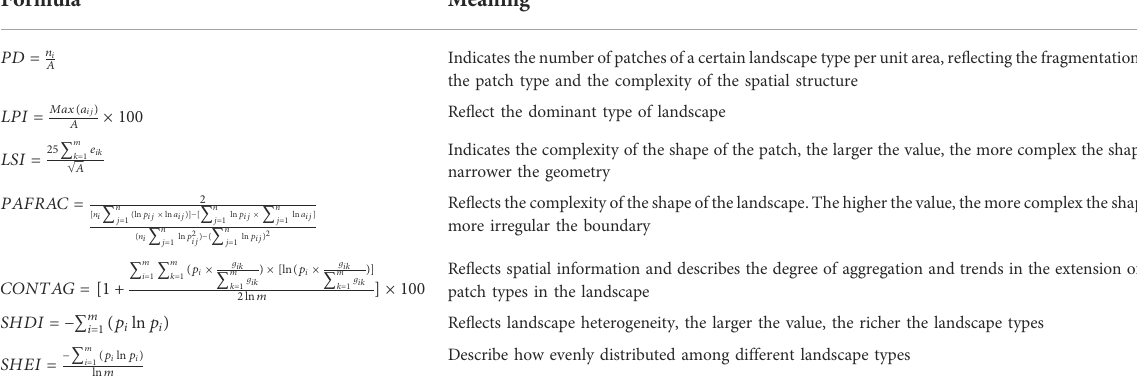
TABLE 3 Formula and signi fi cance of landscape pattern index. Formula